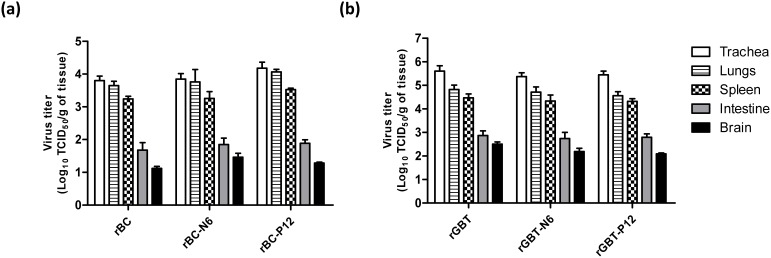
Virus titers of rBC and rGBT and their mutants in two-week-old chickens following oculonasal inoculation.Tissue samples from the trachea, lungs, spleen, intestine, and brain of 3 chickens (n = 3) from each indicated virus group were harvested on day 3 post infection, and virus titers were determined by limiting dilution assay [27]. The mean virus titer from 3 chickens per group was given for each tissue sample. Error bars indicate mean±SEM.